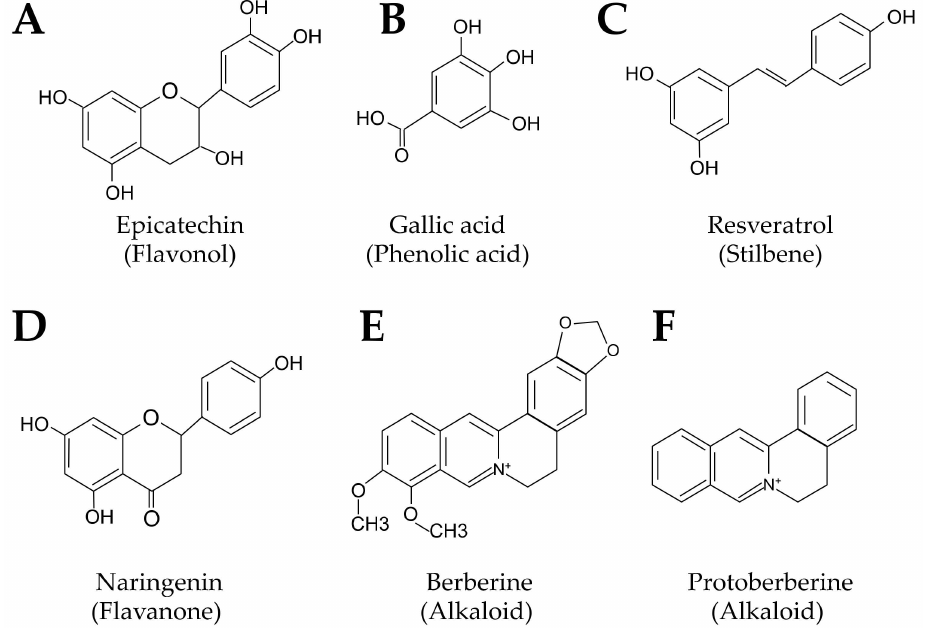
Figure 2. Structure of polyphenols and berberine. Examples of the structure of different types of polyphenols are shown for flavonols ( A ), phenolic acids ( B ), stilbenes ( C ), and flavonones ( D ). The alkaloid berberine ( E ) and the basic structure of protoberberines are also shown ( F